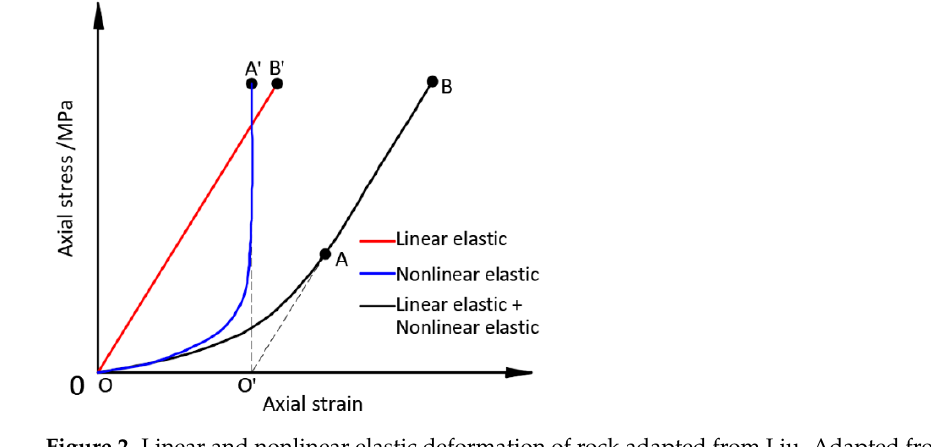
Figure 2. Linear and nonlinear elastic deformation of rock adapted from Liu. Adapted from [30].